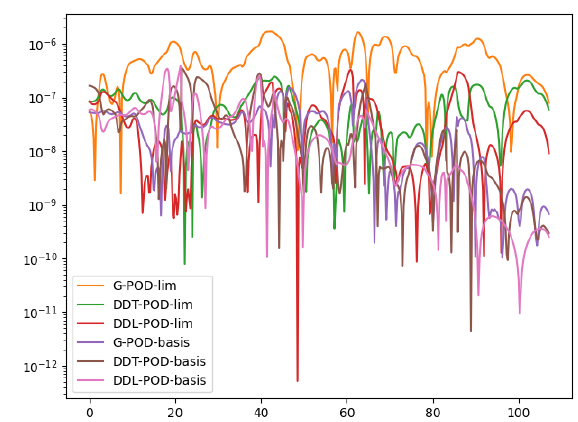
in blue, POD-based ROMs, with the limited number of snap- shots or smart selection of the number of basis functions, in crosses. Figure 16. Scalar flux for Energy Group 1 for the HFM (blue) and POD-based ROMs, with the limited number of snapshots or smart selection of the number of basis functions, in crosses, and the pointwise error between them with parameters R 1 = 2, R 2 = 2, R 3 = 1, R 4 = 1, R 5 =